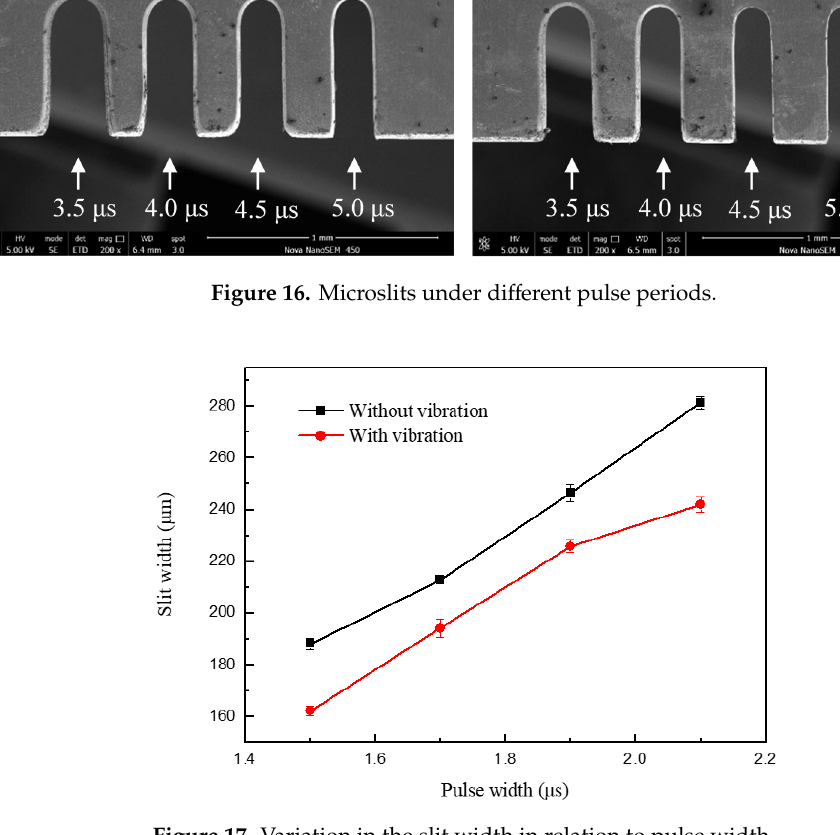
Figure 17. Variation in the slit width in relation to pulse width.